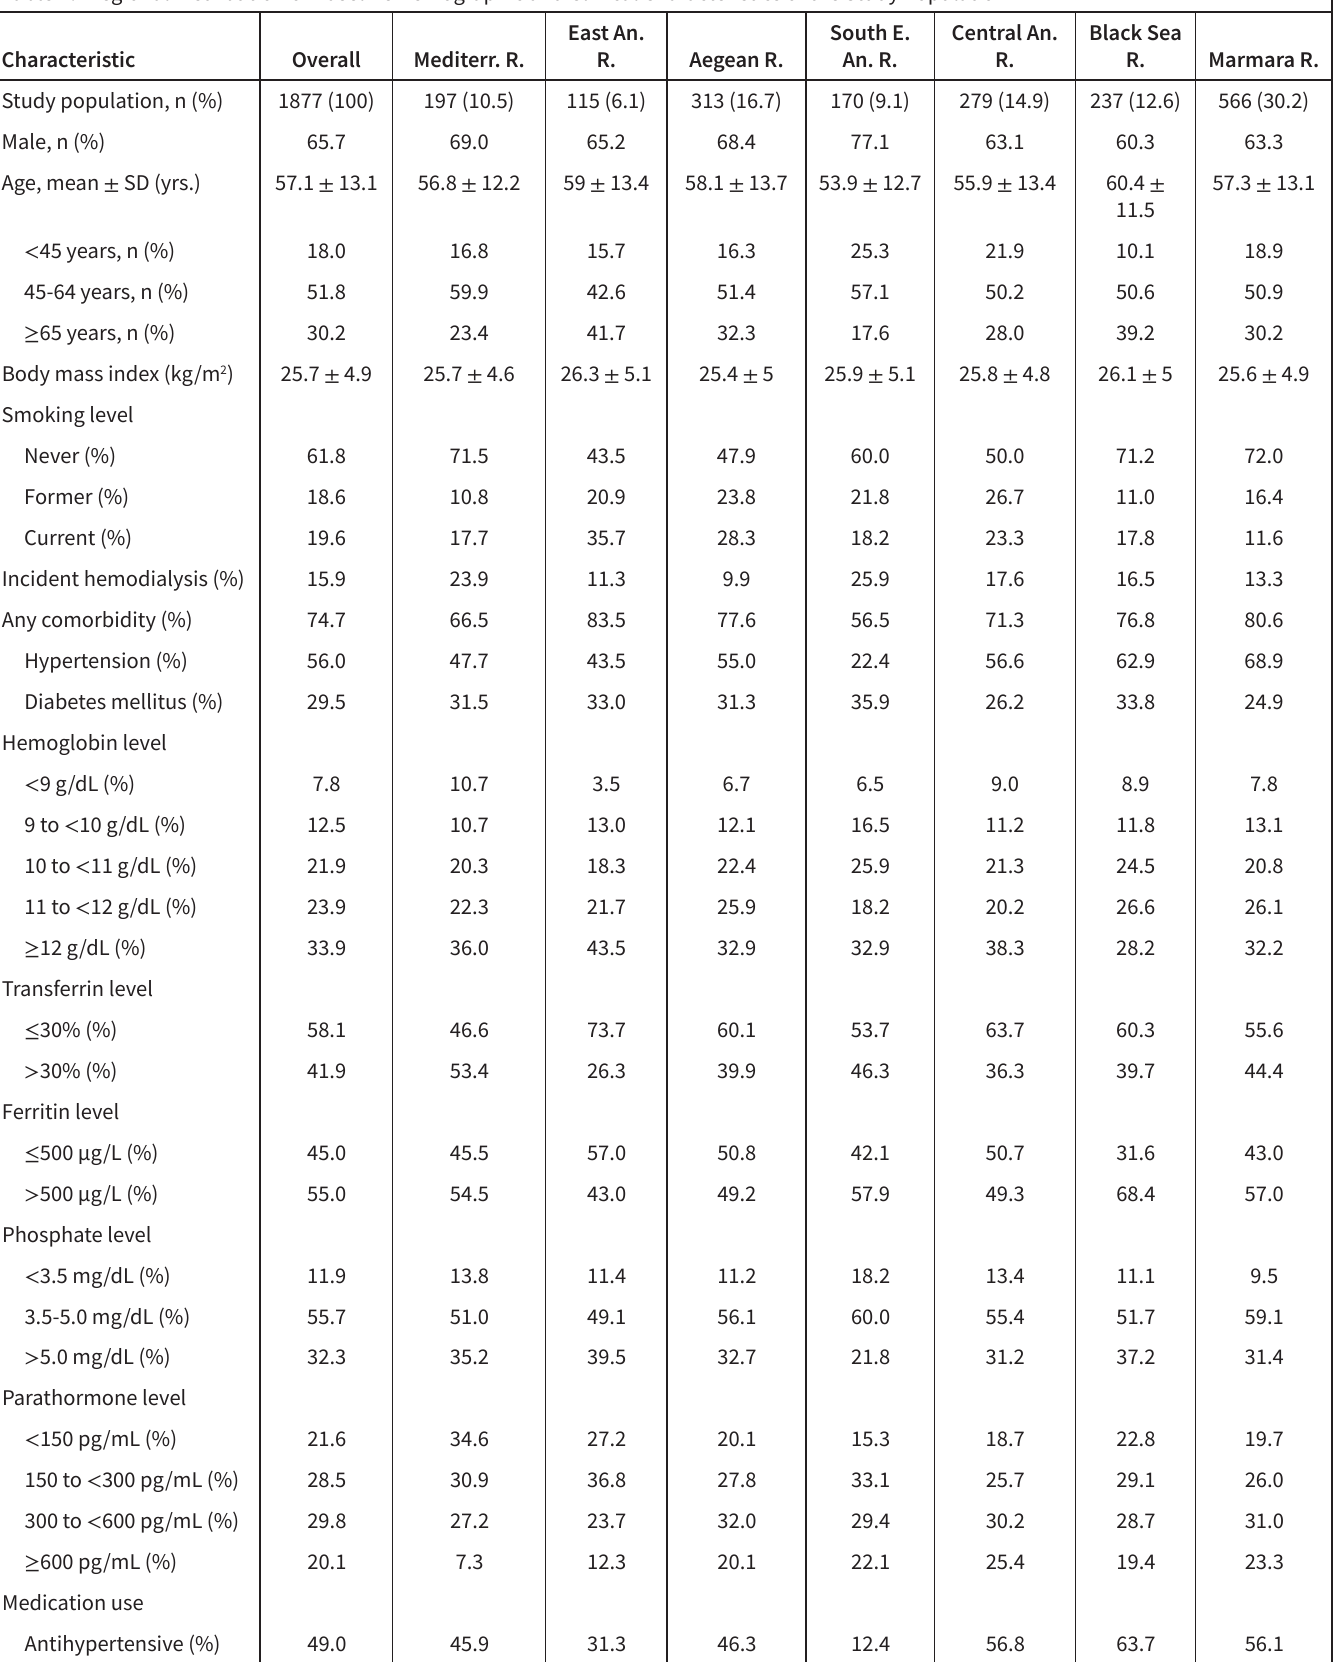
Table 1. Regional Distribution of Baseline Demographic and Clinical Characteristics of the Study Population Characteristic Overall Mediterr. R.